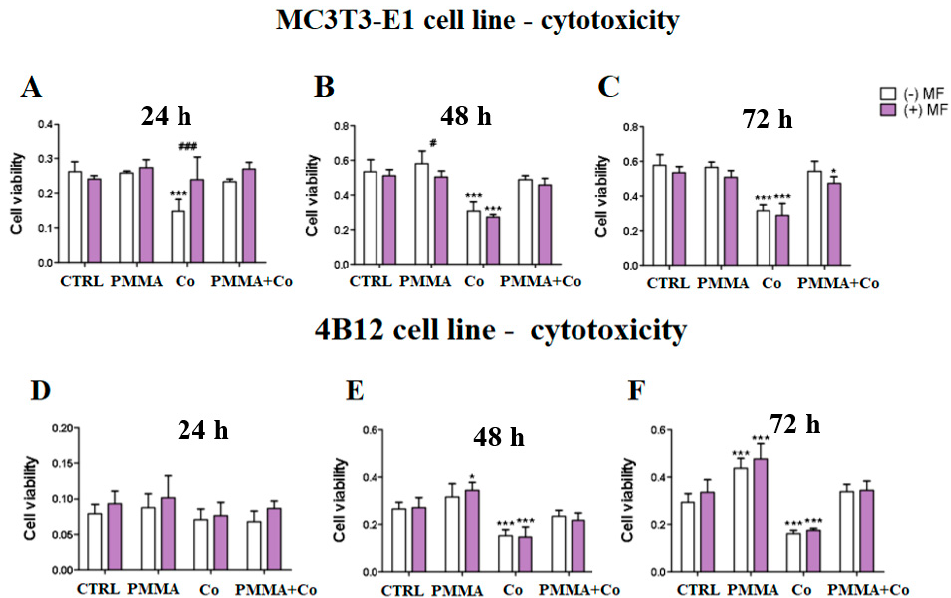
Figure 3. The kinetics of anti-proliferative effects of PMMA and PMMA@Co 0.5 Mn 0.5 Fe 2 O 4 towards mouse pre-osteoblasts (MC3T3-E1 cell line) after 24 h ( A ), 48 h ( B ) and 72 h ( C ) and towards mouse pre-osteoclasts (4B12 cell line) after 24 h ( D ), 48 h ( E ) and 72 h ( F ) in the presence of the magnetic field. Notes: CTRL—control, PMMA—poly(methyl (methylacrylate), Co—Co 0.5 Mn 0.5 Fe 2 O 4 , PMMA